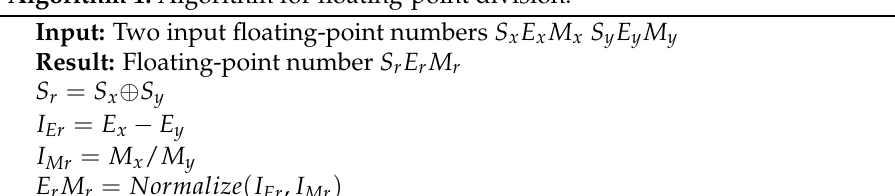
Algorithm 1: Algorithm for floating-point division.